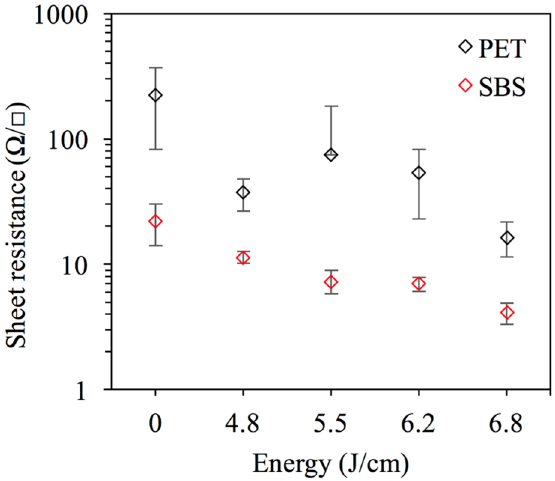
Figure 12. Sheet resistance of Ni ink on SBS paperboard and PET.